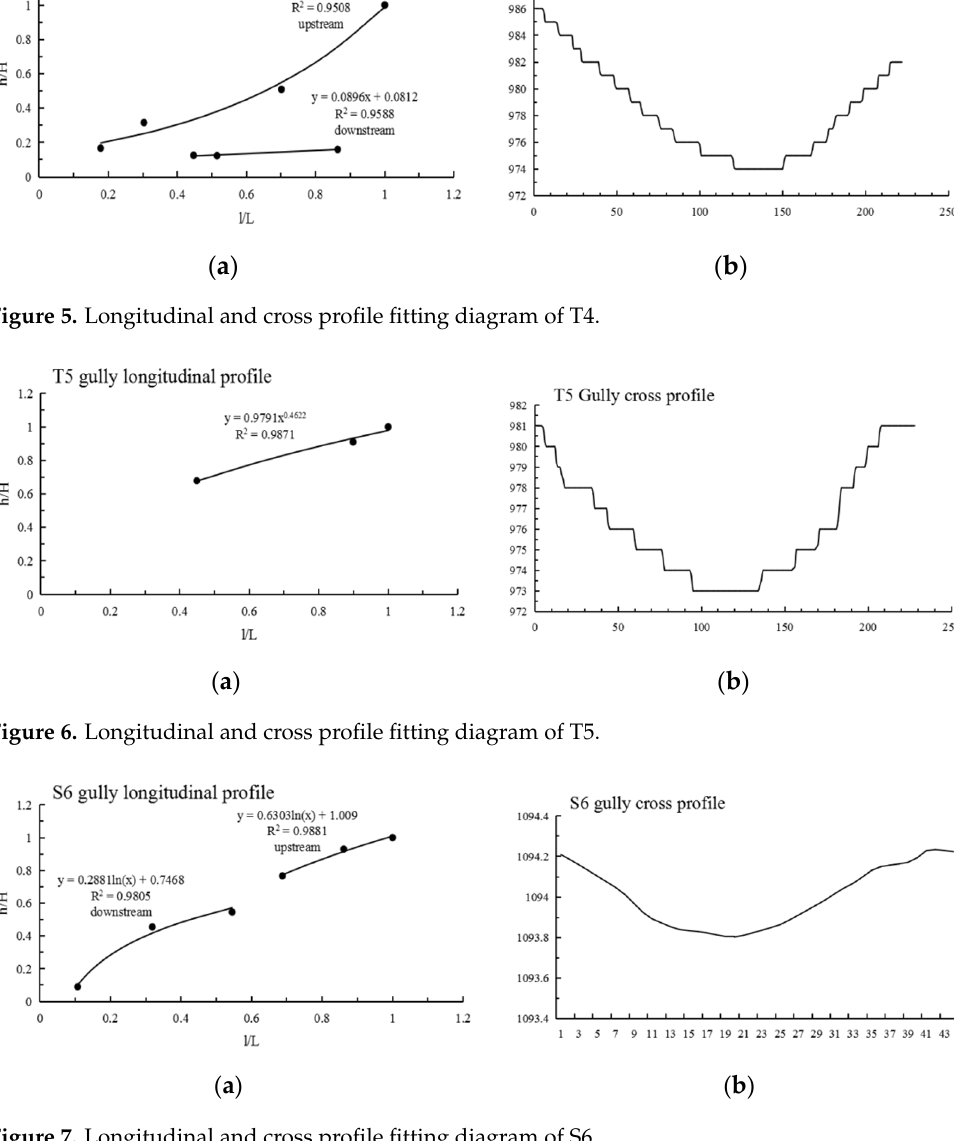
( b ) ( b ) Figure 8. Longitudinal and cross profile fitting diagram of S11. ( b ) Figure 8. Longitudinal and cross profile fitting diagram of S11.